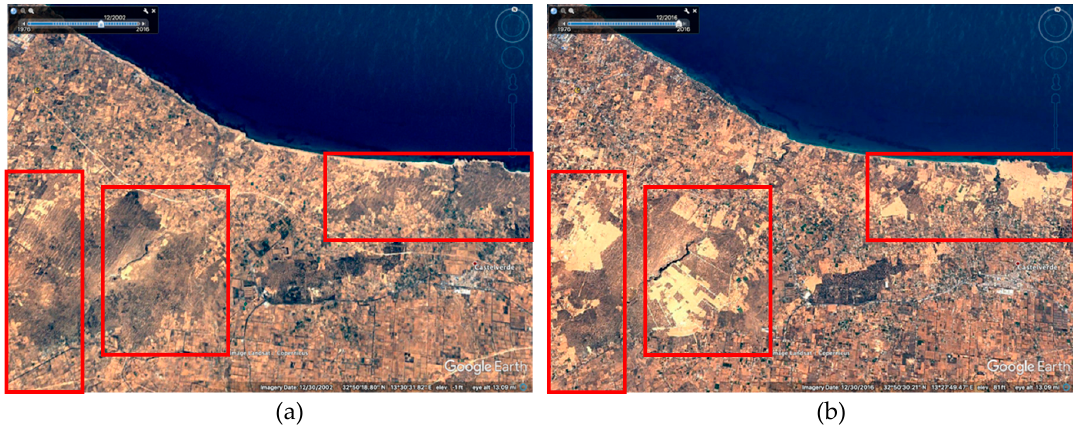
Figure 12. Deforestation in the northwestern coastal areas stretching from Tajoura to Misurata (northeast Tripoli): ( a ) before December 2012, ( b ) after December 2016 [57].